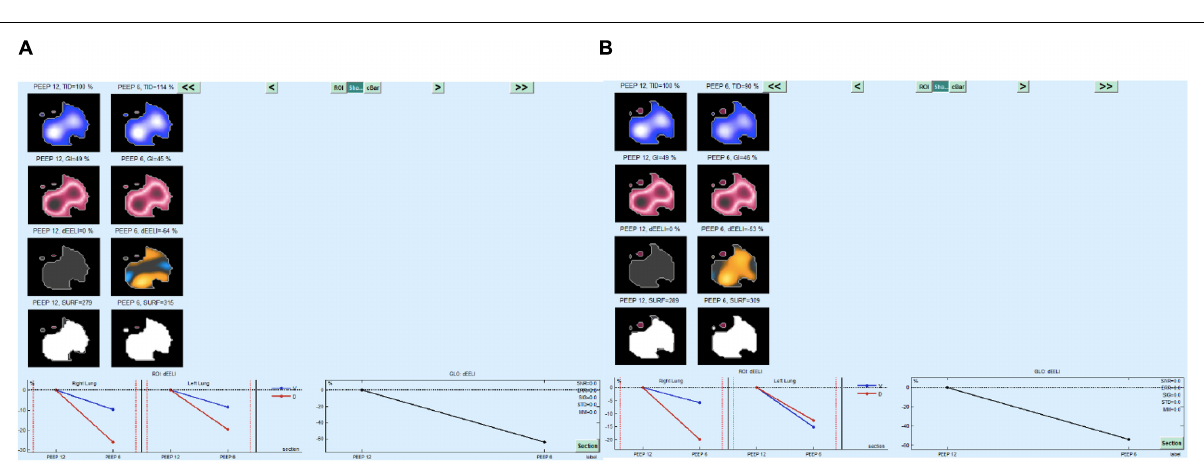
19 (Whang et al., 2021) did not recommend NIV in such